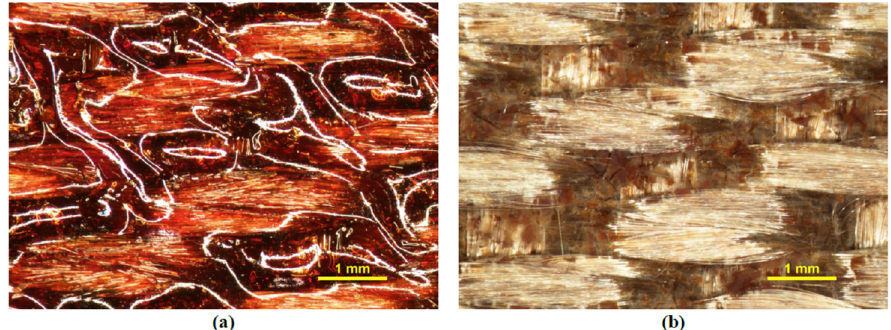
Figure 10. Optical microscopy images comparing Nextel 312/poly(BAF-oda-fu-POSS) composite surface features ( a ) before and ( b ) after ground-based atomic-oxygen erosion testing.